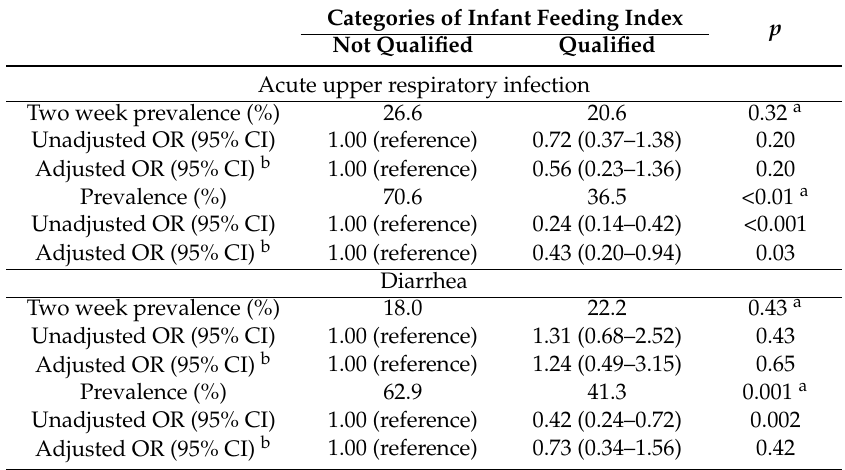
Table 4. Disease status as related to two categories of feeding practices index. Categories of Infant Feeding Index